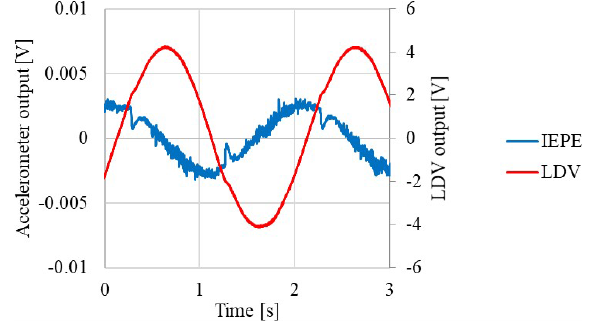
Figure 11. Raw data from the IEPE accelerometer and the LDV.